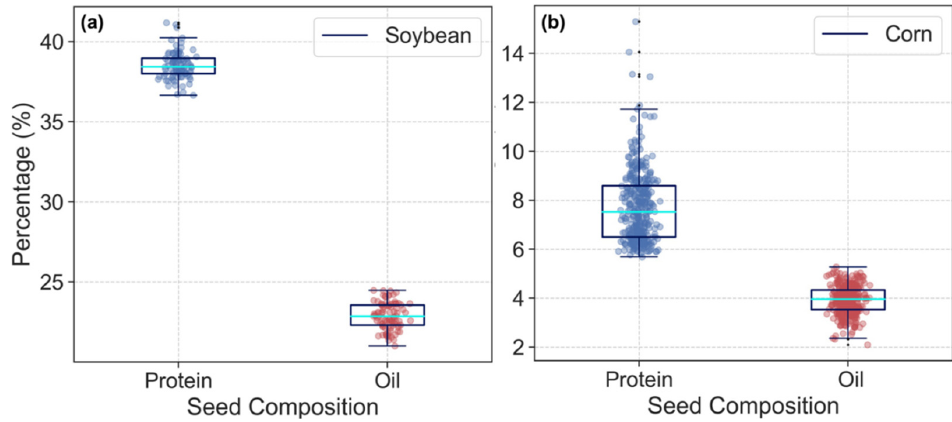
Figure 11. Distribution of the soybean ( a ) and corn ( b ) seed protein and oil concentration of all samples used in this study.